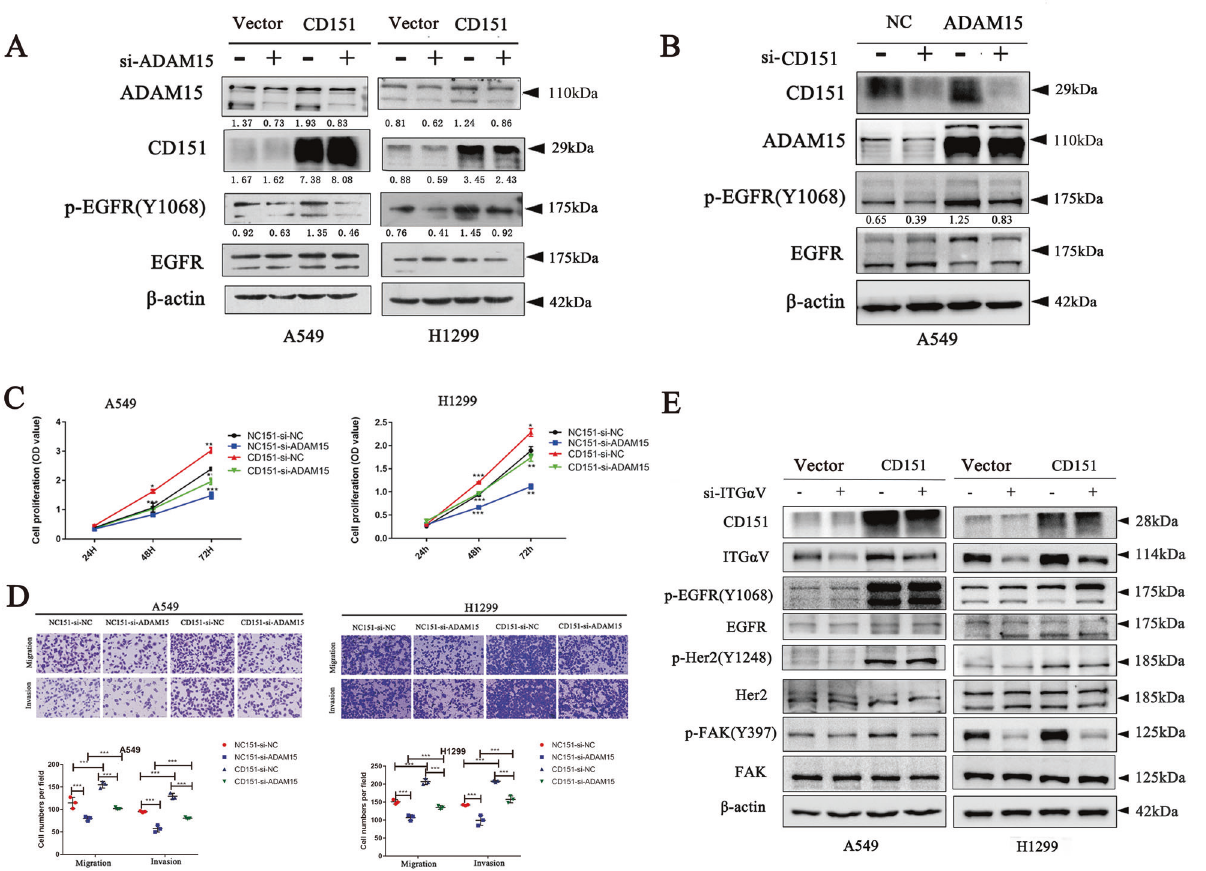
Fig. 7 ADAM15 and CD151 cooperate to affect the integrin-related EGFR signalling pathway. A Control and CD151-overexpressing stable A549 and H1299 cells were transfected with the indicated siRNA (si-ADAM15 compared with si-NC) followed by western blotting. β -actin was used as a loading control. B Control and ADAM15-overexpressing stable A549 cells were transfected with the indicated siRNA (si-CD151 compared with si-NC) followed by western blotting. β -actin was used as a loading control. C , D CD151-overexpressing stable A549 and H1299 cells were transfected with the indicated siRNA (si-ADAM15 compared with si-NC) followed by CCK-8 and Transwell assays. E Control and CD151-overexpressing stable A549 and H1299 cells were treated with the indicated siRNA (si- α V compared with si-NC) followed by western blotting. β -actin was used as a loading control. * P < 0.05; ** P < 0.01; *** P <